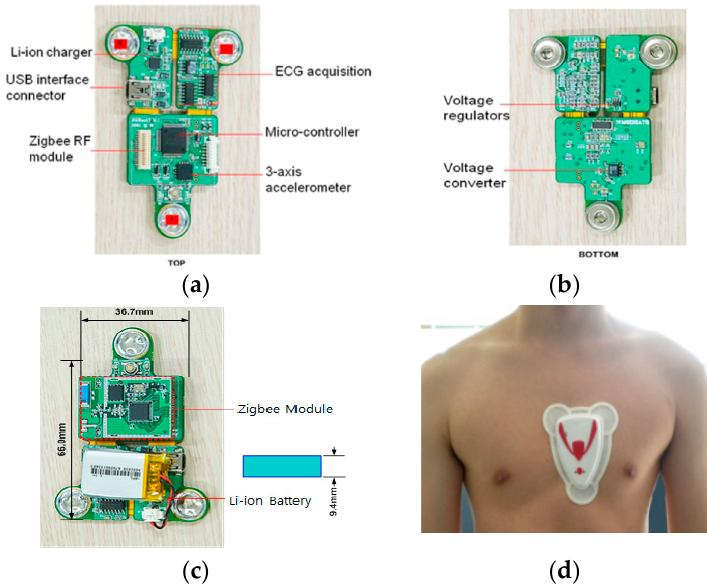
Figure 6. Sensor node: ( a ) top; ( b ) bottom; ( c ) packed with RF module and battery; ( d ) silicone-covered sensor node patched on athlete’s chest. USB = universal serial bus.